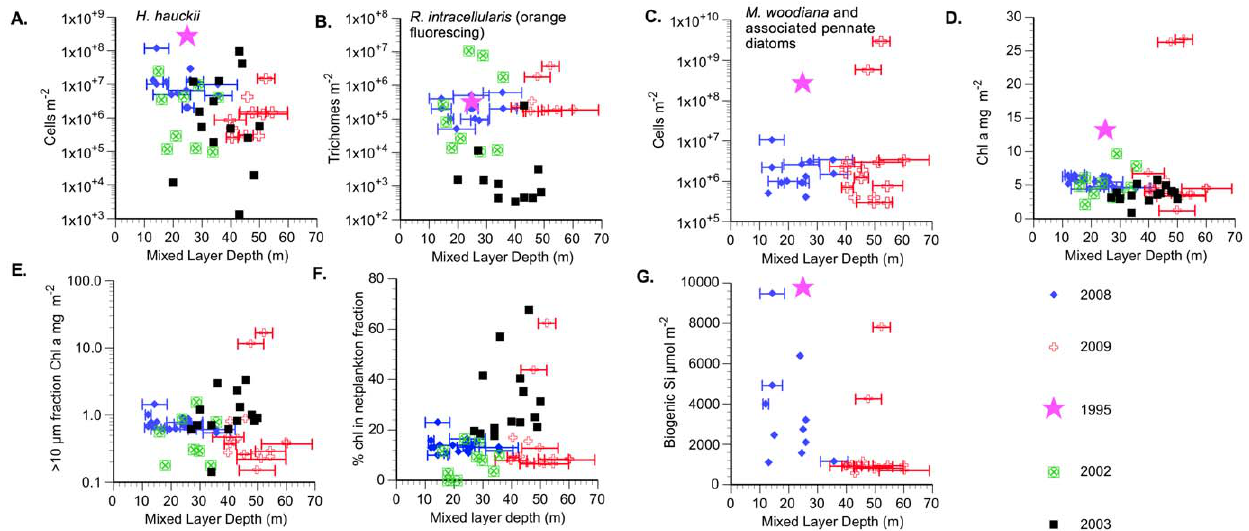
Figure 7. Mixed layer depth versus 0–60 m integrated biomass and abundance. Error bars represent the range of mixed layer depths observed in multiple CTD casts at individual stations. A. H. hauckii , B. Orange-fluorescing Richelia intracellaris trichomes (filaments) enumerated from 2 liter filtered samples, C. Mastogloia woodiana and associated small pennate diatoms, D. Total ( . 0.45 m m) chl a, E. . 10 m m fraction chl a, F. % chl a in . 10 m m size fraction, G. Biogenic silica ( . 0.6 m m fraction). See methods for 1995, 2002, and 2003 regional data sources.